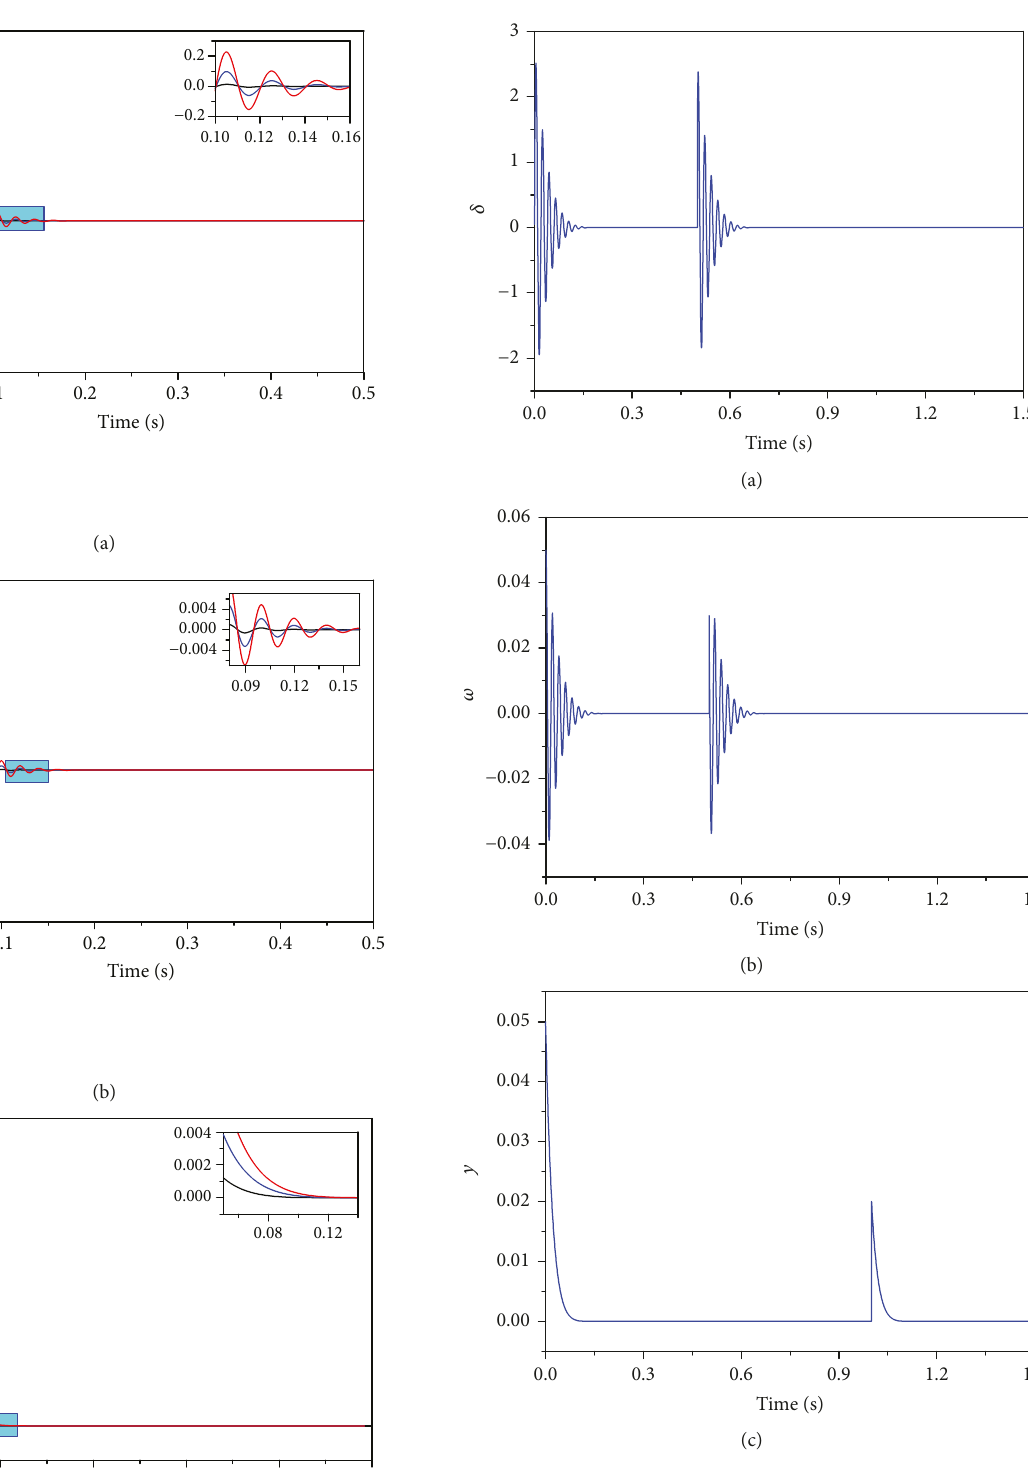
Figure 4: The response of the system with the di ff erent